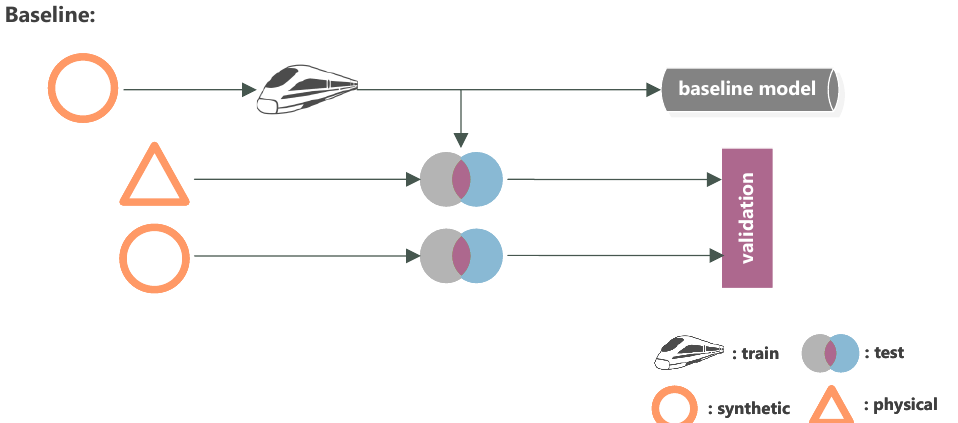
Figure 5. Baseline benchmark. The networks are trained on synthetic data and validated on both a synthetic and physical test set. This experiment shows the base function and the quality of training with synthetic